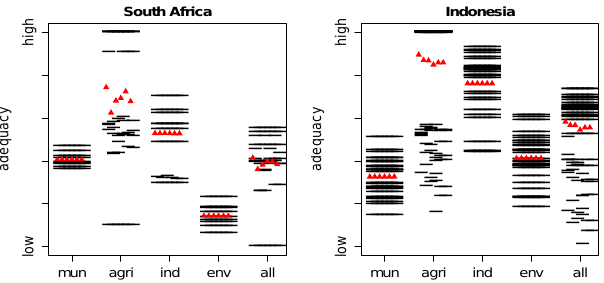
Figure 5. Sectoral water adequacy in South Africa (left) and Indonesia (right), showing results for the individual sec- tors (mun=municipal, agri=agricultural, ind=industrial, env=environmental, all=overall). Black lines show results for the individual municipalities, and red triangles show the country average for results across models and RCPs from left to right: GDFLbase, GDFL2.6, GDFL8.5, HADbase, HAD2.6,